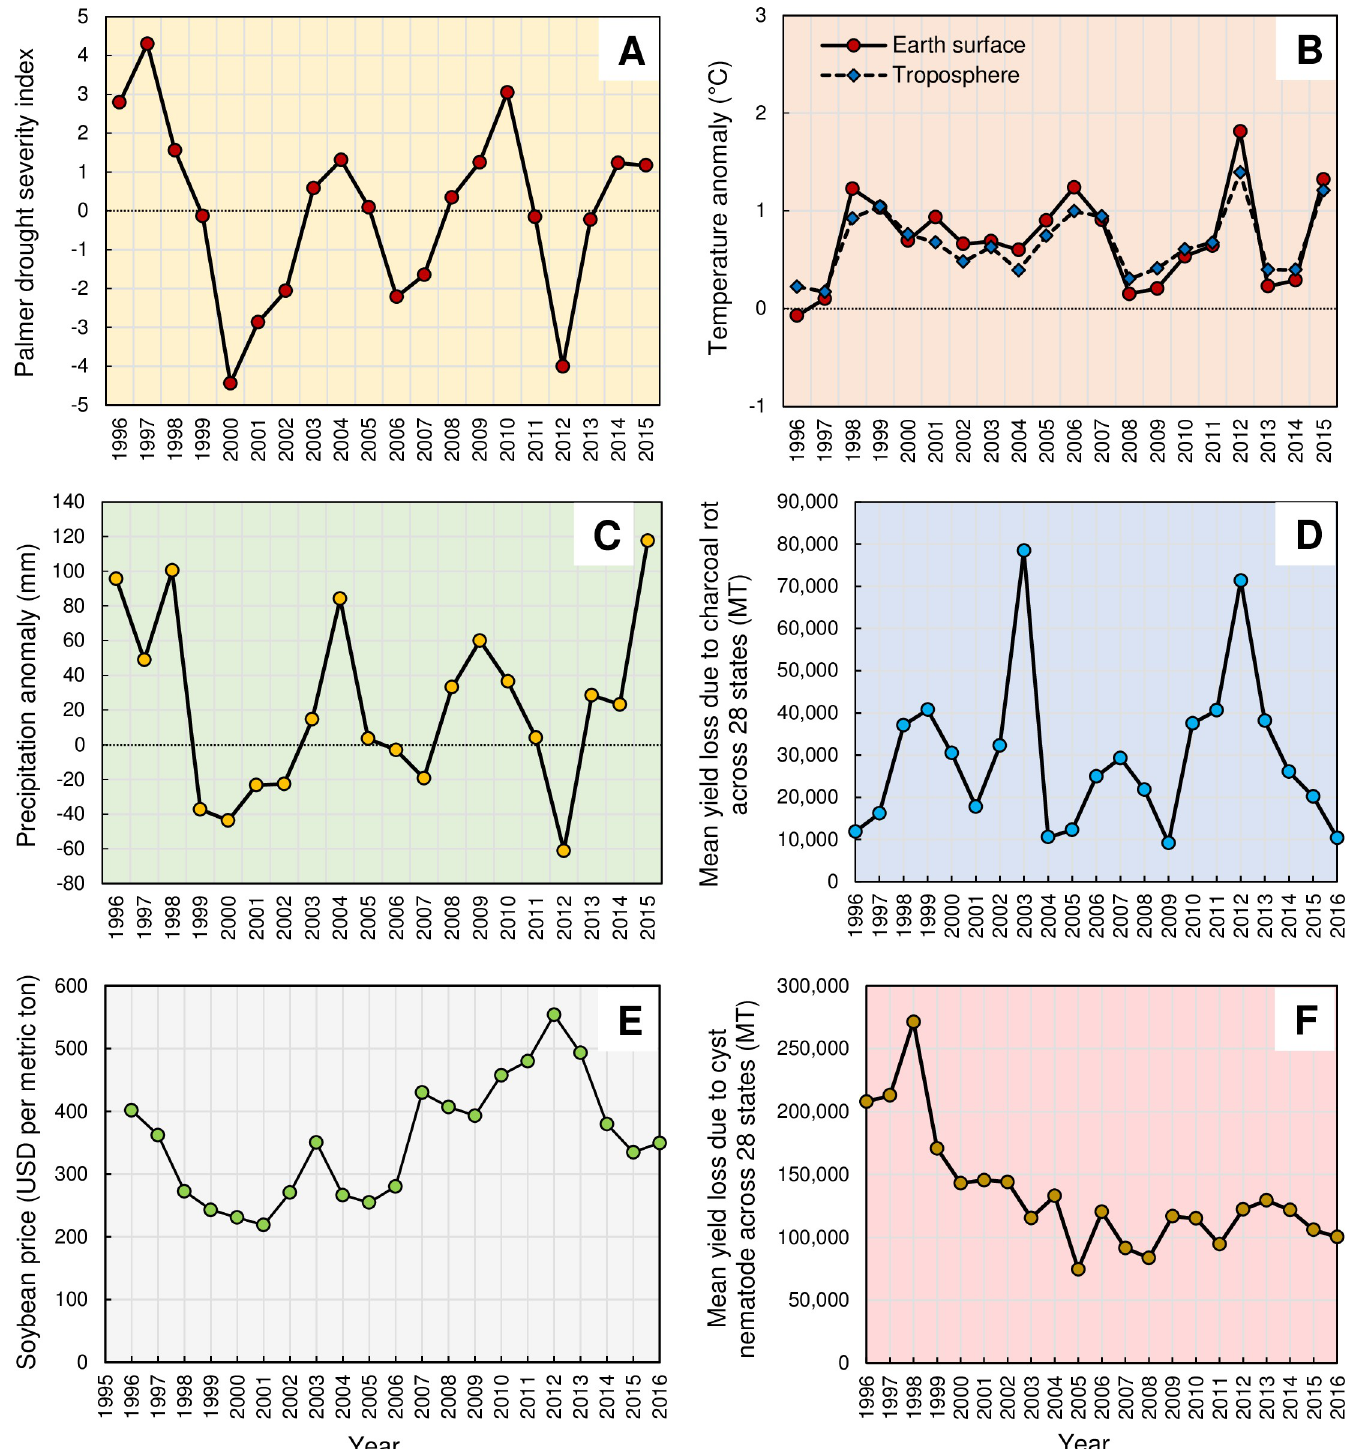
Fig 8. (A) Annual values of the Palmer Drought Severity Index, averaged over the entire area of the contiguous 48 states. Positive values represent wetter-than-average conditions, while negative values represent drier-than-average conditions. A value between -2 and -3 indicates moderate drought, -3 to -4 is severe drought, and -4 or below indicates extreme drought. ( B ) Annual average temperature in the contiguous 48 states. ( C ) Total annual precipitation in the contiguous 48 states. Graph uses the 1901 to 2000 average as a baseline for depicting change. Selecting a different baseline period would not change the shape of the data over time. Data for figures were obtained from the National Oceanic and Atmospheric Administration’s National Centers for Environmental Information (www7.ncdc.noaa.gov.). ( D ) The annual